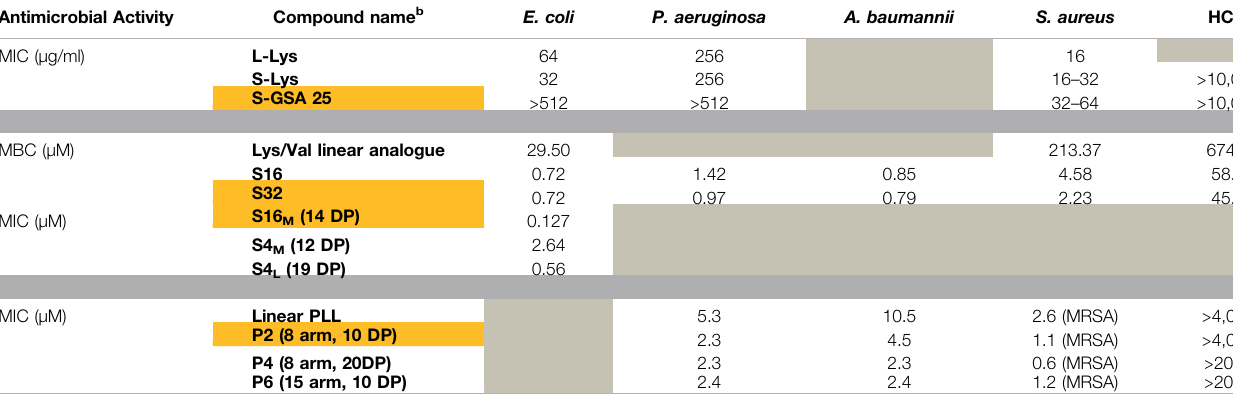
The bold values/text is to highlight the compounds, the meaning of each of these is in the text a References: (Lam et al., 2016a; Shirbin et al., 2018; Lu et al., 2019). b Highlighted in orange are the lead compounds for each class of star-shaped